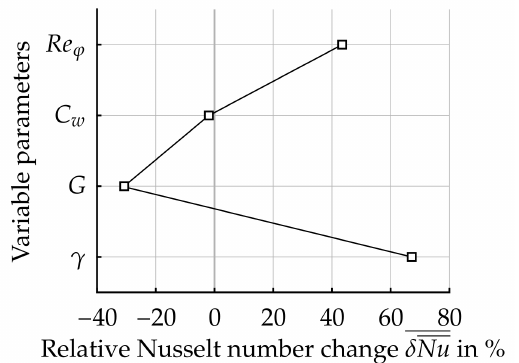
Figure 7. Main effects of all variable parameters on the averaged relative Nusselt number change δ Nu